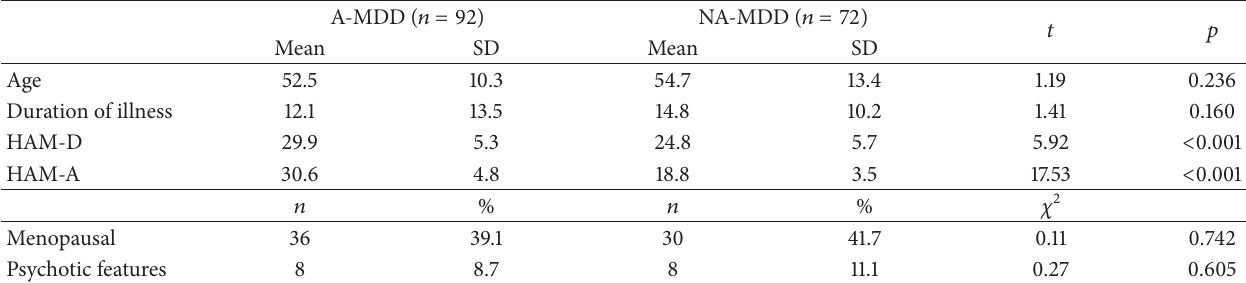
Table 1: Demographic and clinical characteristics of the sample.